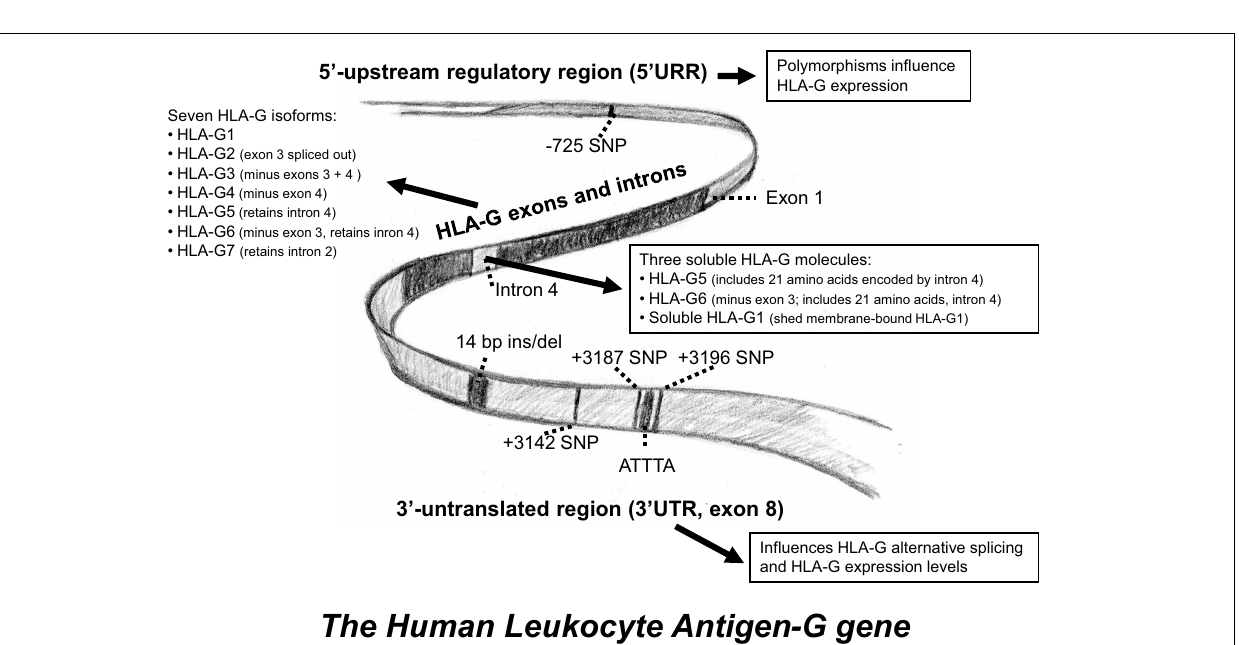
FIGURE 2 |A schematic representation of the HLA-G gene . Some of the most intensively studied gene polymorphisms in the 5 (cid:48) -upstream regulatory region and in the 3 (cid:48) -untranslated region. An overview of the different HLA-G isoforms is included.